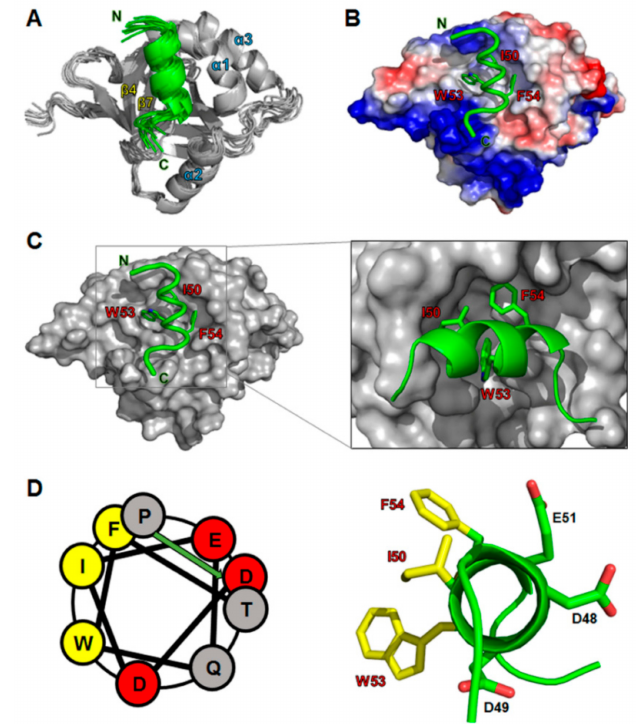
Figure 4. A structural model of the MED25 ACID/p53TAD2 peptide complex. ( A ) An ensemble of eight structural models are shown. MED25 ACID and p53TAD2 peptide are shown in gray and green, respectively; ( B ) Positive and negative electrostatic potentials on the molecular surface of MED25 ACID are colored in blue and red, respectively; ( C ) Molecular surface representation of the MED25 ACID (gray) complexed with p53TAD2 peptide (green); ( D ) The helical wheel diagram of p53TAD2